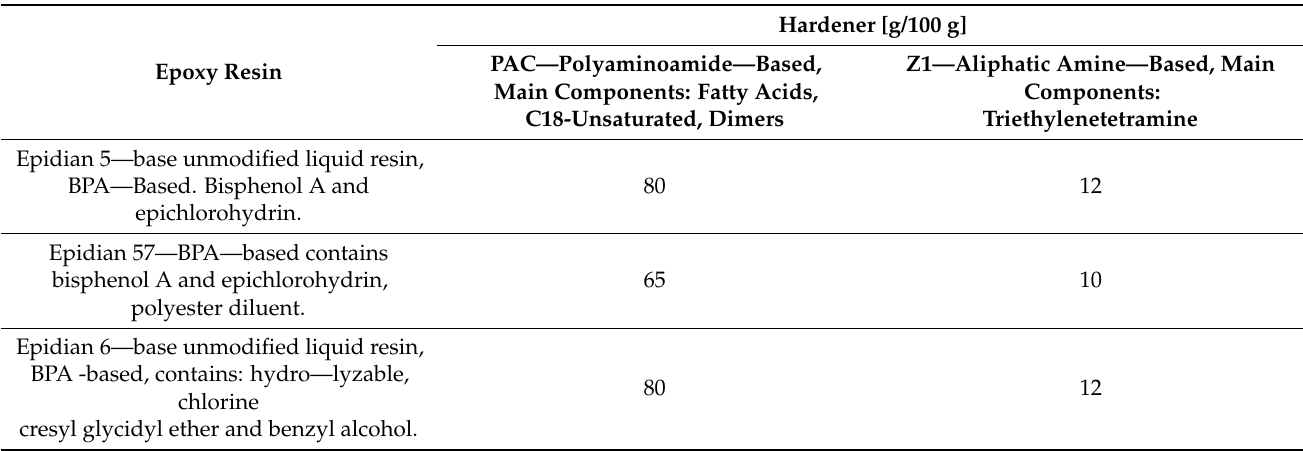
Table 1. Table of main components of epoxy resins and hardeners with weight ratios of the used adhesive